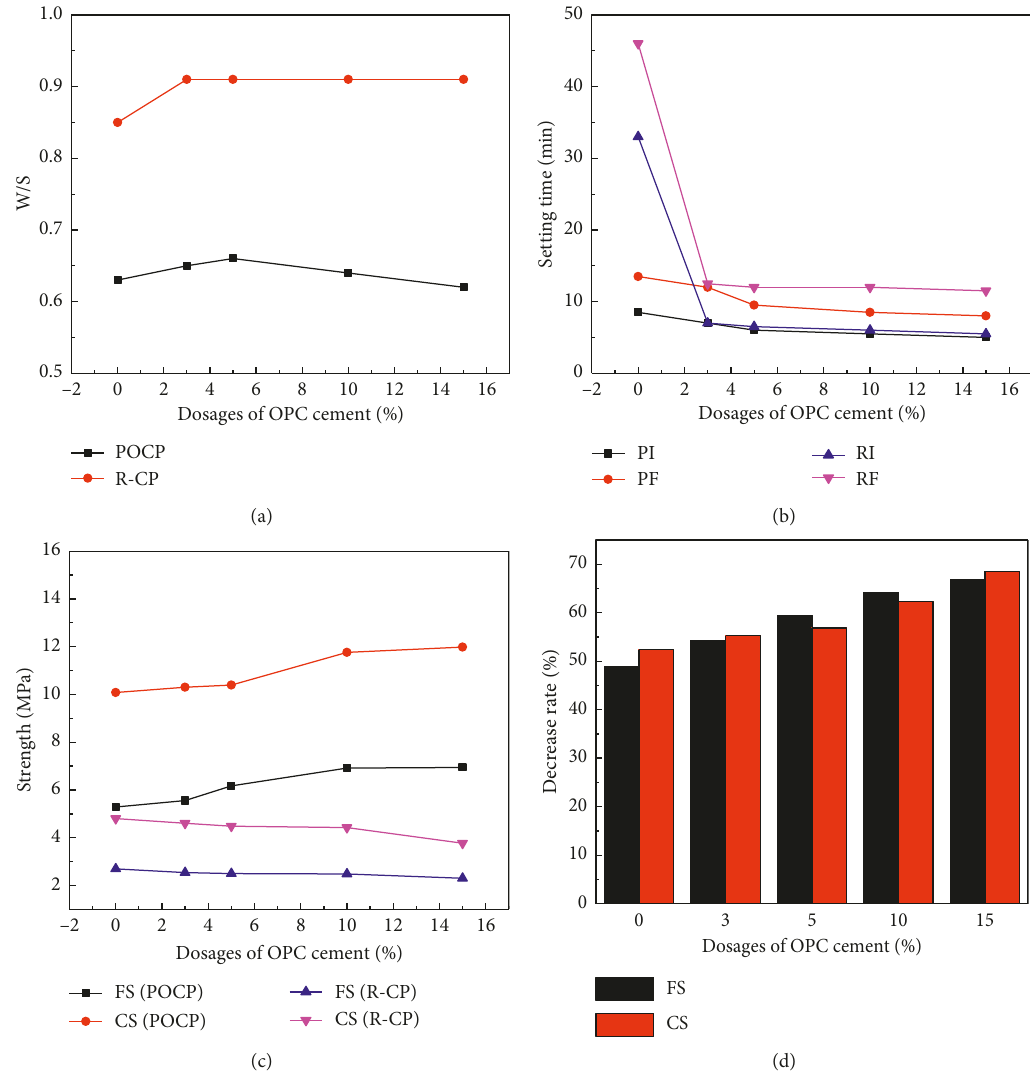
Figure 5: Macroproperties of R-CP: (a) water-solid ratio of R-CP; (b) setting time of R-CP; (c) strength of R-CP; (d) strength decrease rate of R-CP. PI: initial setting time of POCP; PF: final setting time of POCP; RI: initial setting time of R-CP; RF: final setting time of R-CP; FS: flexural strength; CS: compressive